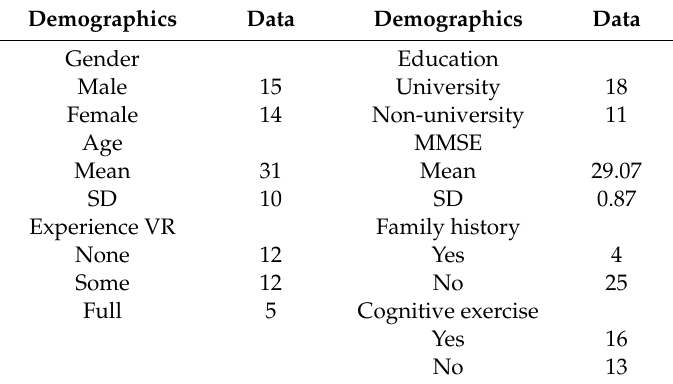
Table 2. Characteristics of the